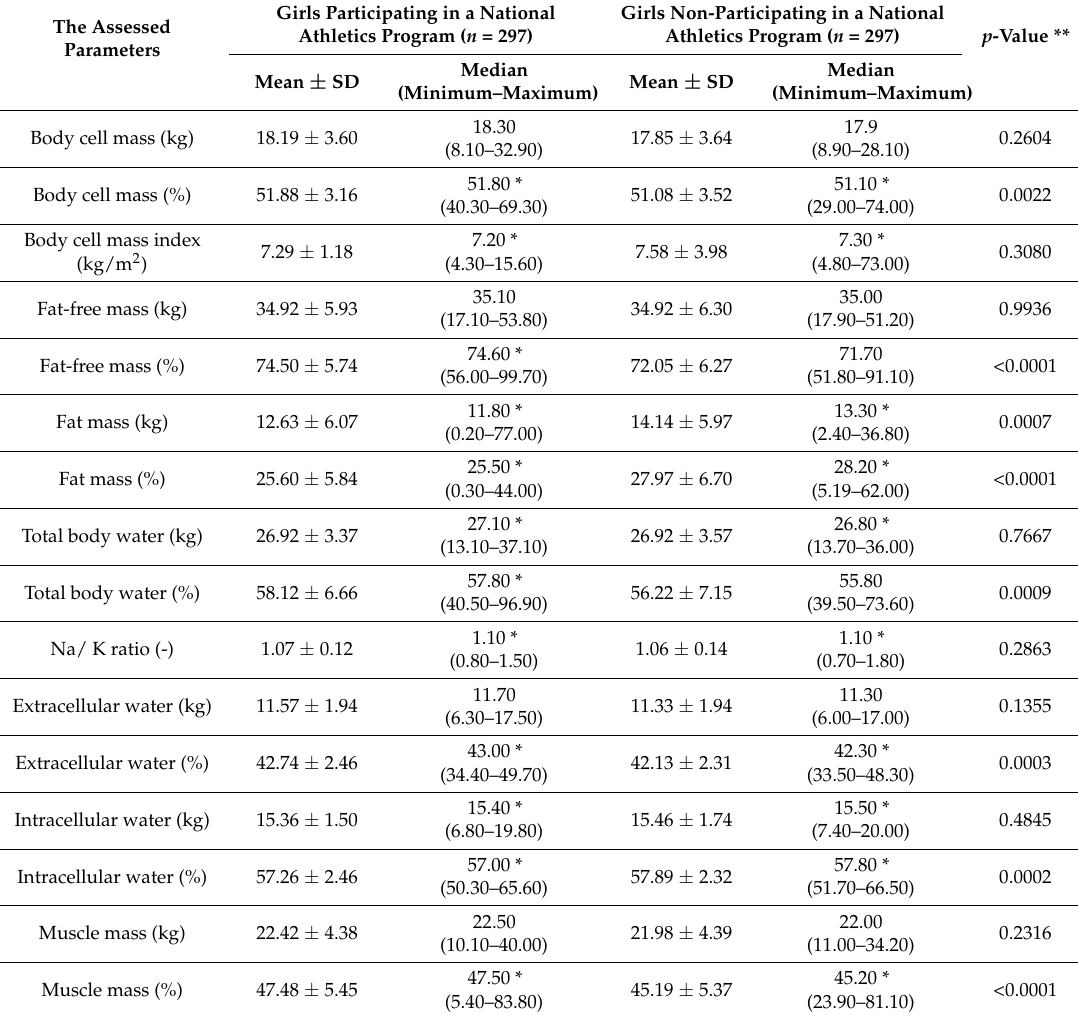
Table 7. The body composition in group of girls participating in a national athletics program and pair-matched control group of